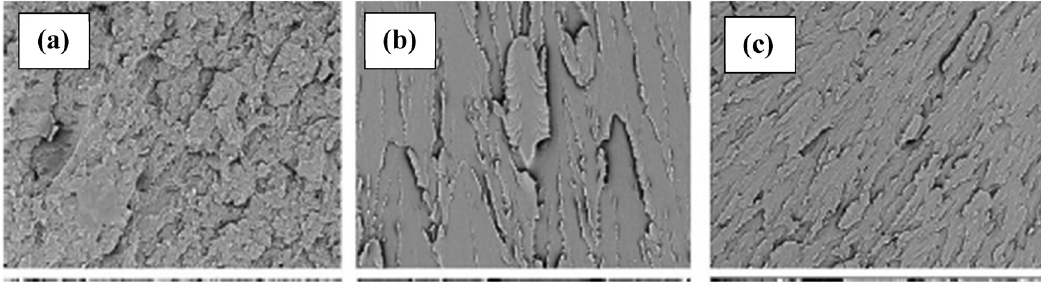
Figure 4: Fracture surface of broken tensile specimens of ( a ) CNC_d, ( b ) CNC_h, and ( c ) CNC_a. Adapted from ref. [ 34 ]